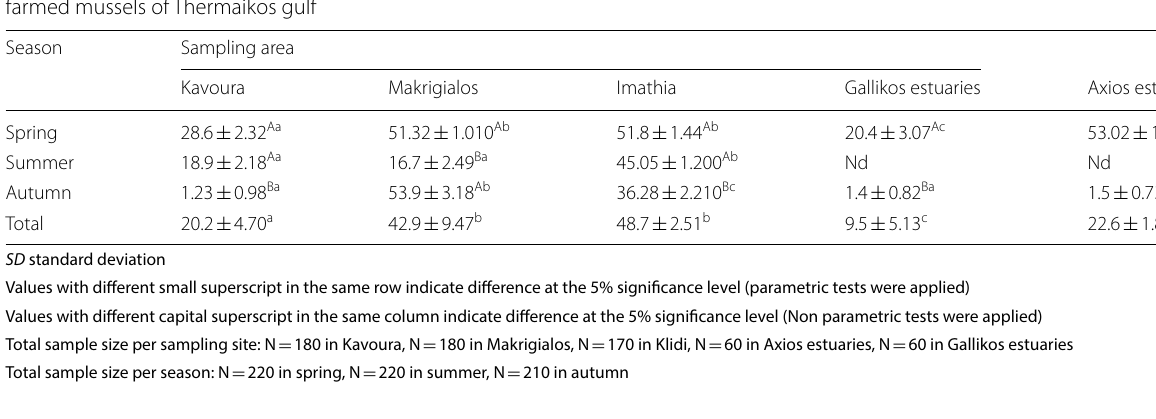
SD, ng g − 1 ) of digestive gland in ±